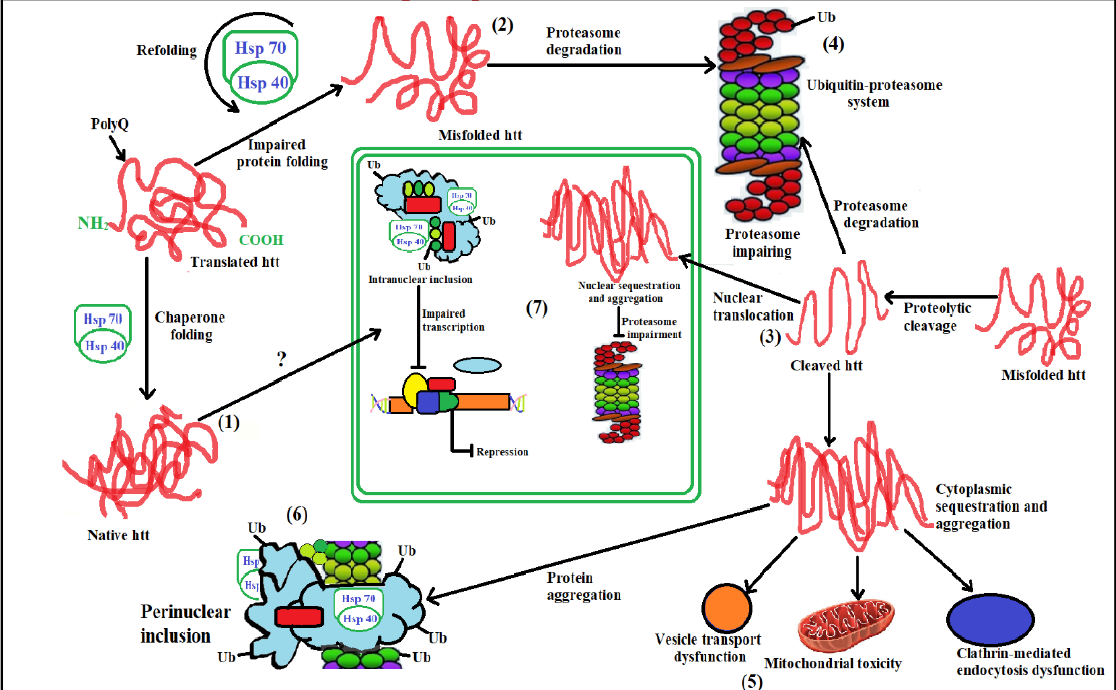
Figure 5. Steps in cellular pathogenesis of HD. ( 1 ). Huntingtin (htt), a freshly generated protein, is encouraged to fold into a native shape by the molecular chaperones Hsp70 and Hsp40. Wild-type htt is primarily cytoplasmic and likely participates in postsynaptic signaling, clathrin-mediated endocytosis, vesicle transport, cytoskeletal anchoring, or neuronal transport. HTT might enter the nucleus and influence the control of transcription; ( 2 ). In order to promote either their refolding or their ubiquitination (Ub) and subsequent demise by the 26S proteasome, chaperones can help recognize aberrant proteins. If chaperones are not present to rectify the incorrect folding of htt caused by the HD mutation, misfolded htt will accumulate in the cytoplasm. The HD mutation causes conformational alterations; ( 3 ). Alternately, mutant htt may also be cleaved by proteolysis, resulting in amino-terminal fragments that produce β -sheet structures; ( 4 ). Finally, cleaved N-terminal fragments, which may form soluble monomers, oligomers, or huge insoluble aggregates, or full-length mutant htt may cause toxicity. Mutant versions of htt may damage the ubiquitin-proteasome system (UPS) in the cytoplasm, causing a buildup of more improperly folded proteins; ( 5 ). These harmful proteins may also interfere with clathrin-mediated endocytosis and regular vesicle transport. Additionally, the presence of mutant htt may cause mitochondrial damage, which would directly or indirectly activate pro-apoptotic proteins and increase cellular toxicity as well as other negative effects; ( 6 ). The cell gathers harmful pieces into ubiquitinated cytoplasmic perinuclear aggregates as a form of self-defense; ( 7 ). Furthermore, mutant htt can go into the nucleus and create nuclear inclusions, which can interfere with transcription and the